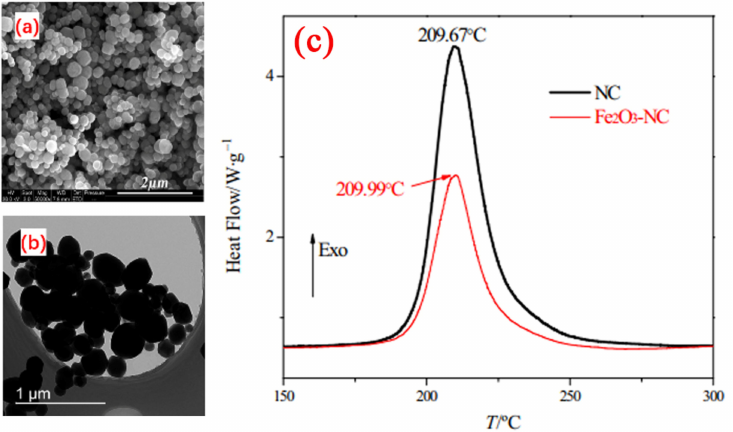
Figure 4. SEM ( a ), Low-magnification TEM ( b ) micrographs of α -Fe 2 O 3 nanoparticles and DSC curves of NC and Fe 2 O 3 -NC ( c ) obtained at a heating rate of 10 ◦ C min –1 . ( a – c ) Reproduced with the permission of ref. [40]. Copyright 2016, Journal of Analytical and Applied